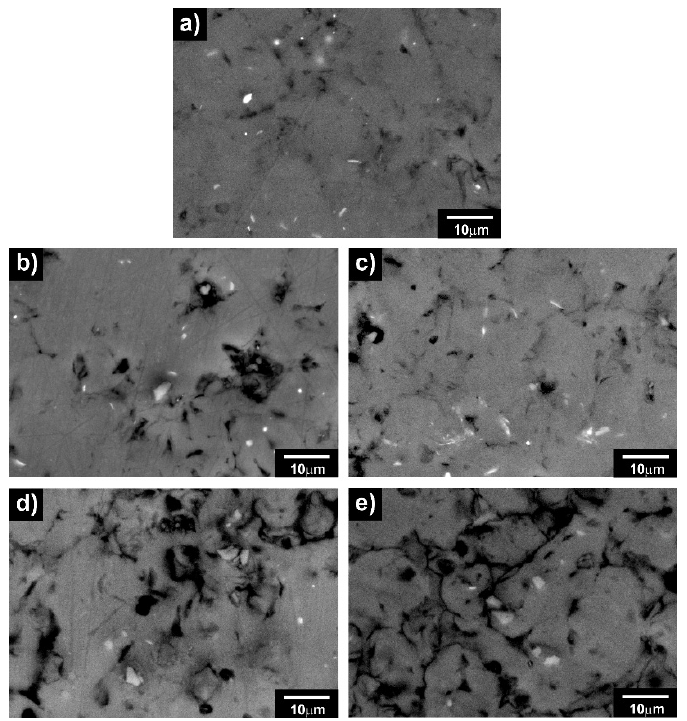
Figure 4. Microstructures of the samples sintered at 601 °C, during 1h. ( a ) Pure aluminum, ( b ) Al-0.5 vol.% WC, ( c ) Al-1 vol.% WC, ( d ) Al-0.5 vol.% Mullite and ( e ) Al-1 vol.% mullite.